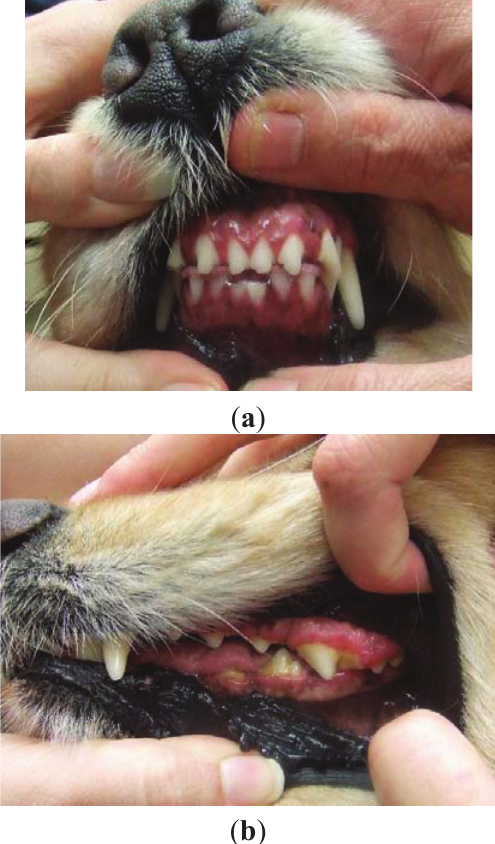
Figure 2. Same dog as in Figure 1(a,b), showing complete clinical remission of gingival overgrowth following 14 weeks of continued azithromycin